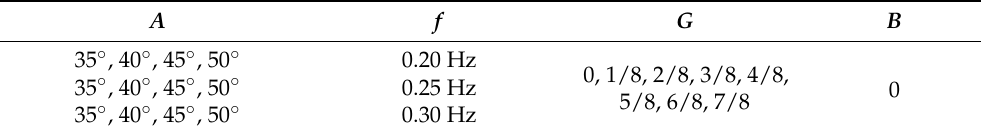
Table 3. High-level control command in sinusoidal-based mode.